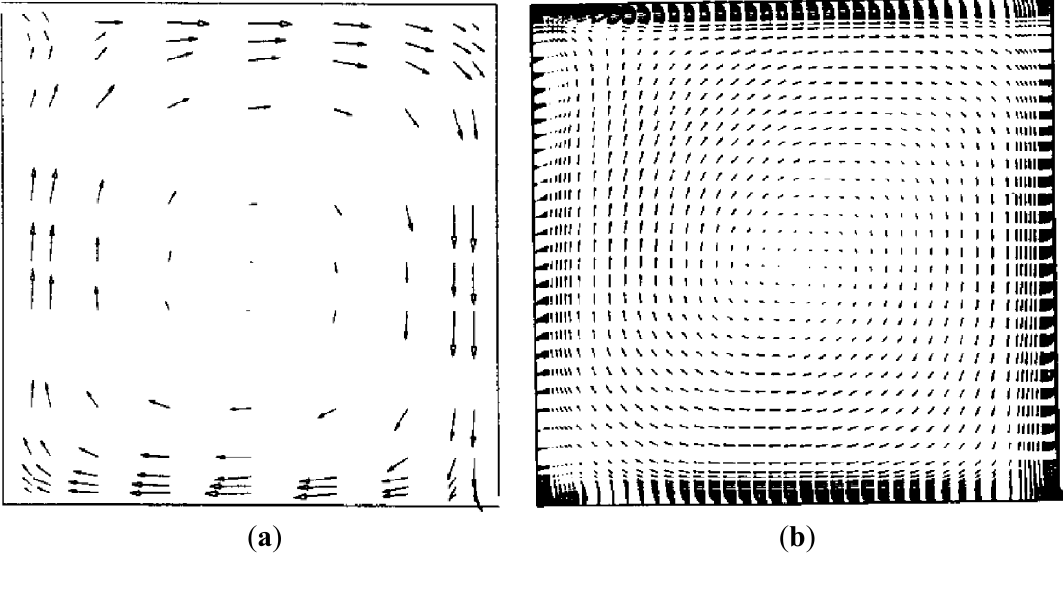
Figure 3. Comparison of velocity distribution between ( a ) experimental measurement [19]; ( b ) large-eddy prediction [20]; and ( c ) present study (streamlines in kg/m·s), together with ( d ) the isotherms (in K) predicted by the present study, for the validation case of turbulent mixed convection in a square